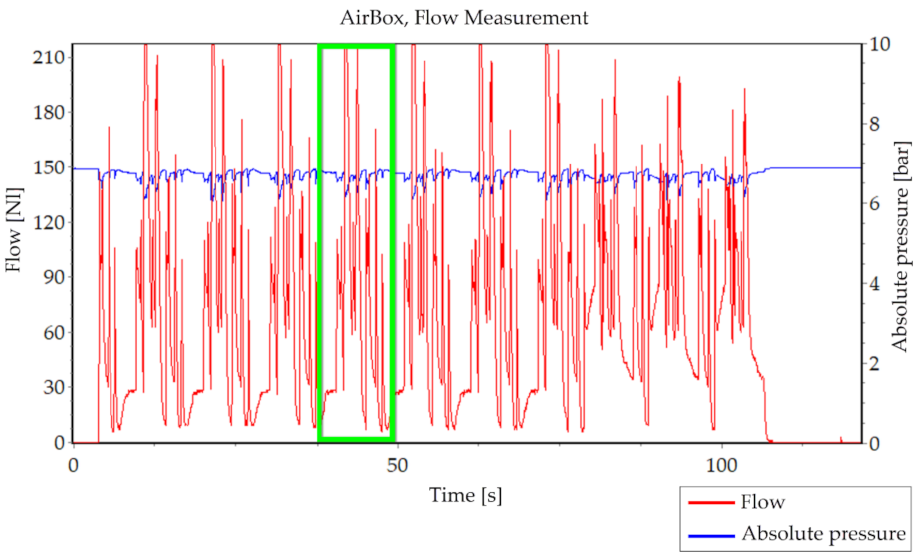
Figure 12. AirBox graph display of compressed air flow measured (red line) and absolute operating pressure (blue line) during one of the